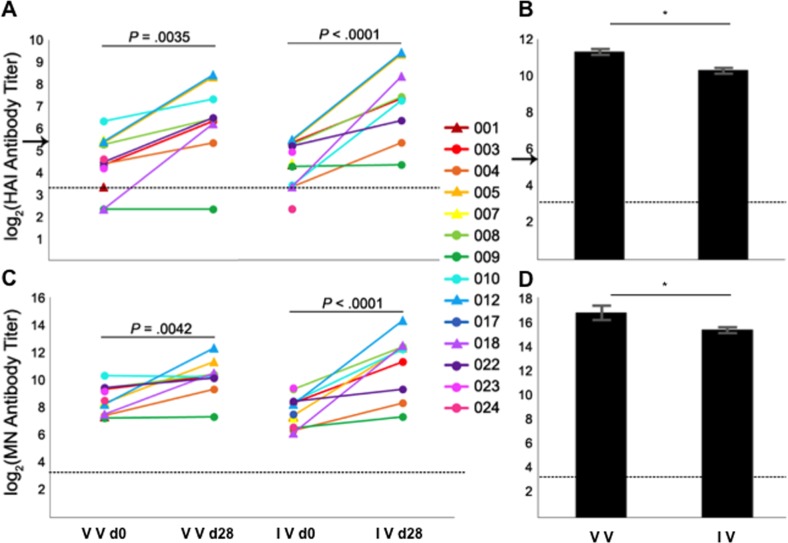
Effect of mutations present in the HA ofin 2015–2016 isolates on the antigenicity of the viral protein.HAI (A and B) and MN (C and D) assays using human (A and C) and ferret (B and D) antisera. Standardized antisera from ferrets infected with the vaccine virus, and human sera collected from infected subjects at the acute (day 0) and post-acute visits 28 days later (day 28), were measured using HAI or MN assays for antibodies specific for the H1N1 vaccine strain (VV) and the virus isolated from patient 022 (IV). The HA protein of the virus isolated from patient 022 encodes mutations found in the majority of 2015–2016 isolates circulating worldwide (S2 Table and Table 1). Individual subject numbers from which the viruses were isolated are shown in the legend. Subjects whose titers are represented with circles received the 2015–2016 flu vaccine, while those represented with triangles were not vaccinated (see S1 Table). Experiments were repeated three times, showing reproducible data. *, indicates p-values <0.05 using a Student’s t-test in B and D. IV, isolated virus. VV, vaccine virus. HAI Ab titer of 40, commonly associated with protection, is indicated by an arrow in (A) and (B) [62,63]. The dotted line indicates the limit of detection (LoD), at an Ab titer of 10. A titer of 5 was considered for titers that fell below the (LoD).